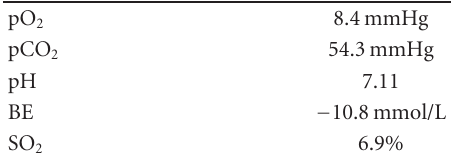
Table 1: Mean blood gas values of the isolated limb after 30 minutes in 185 patients